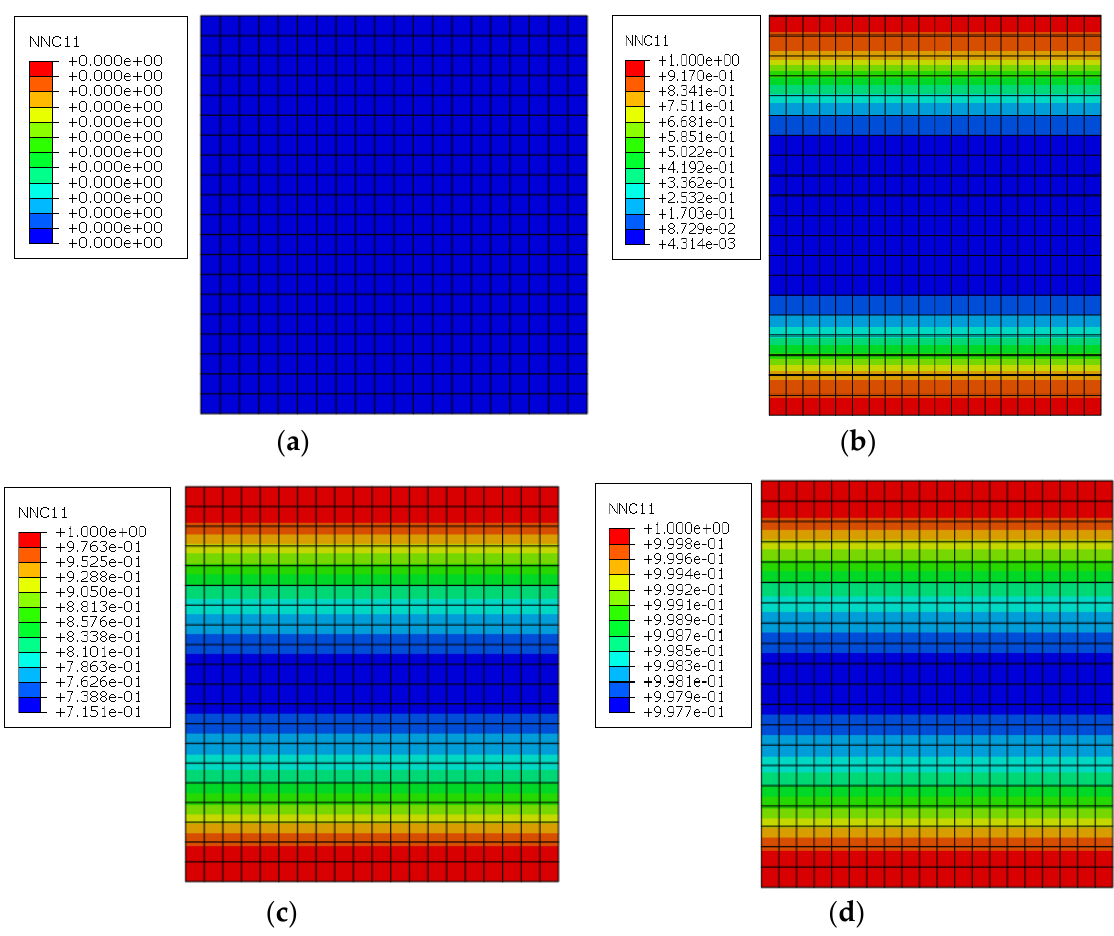
Figure 7. The normalized concentration distribution of sandwich structure: ( a ) t = 0 h; ( b ) t = 20 h; ( c ) t = 200 h; ( d ) t = 800 h.